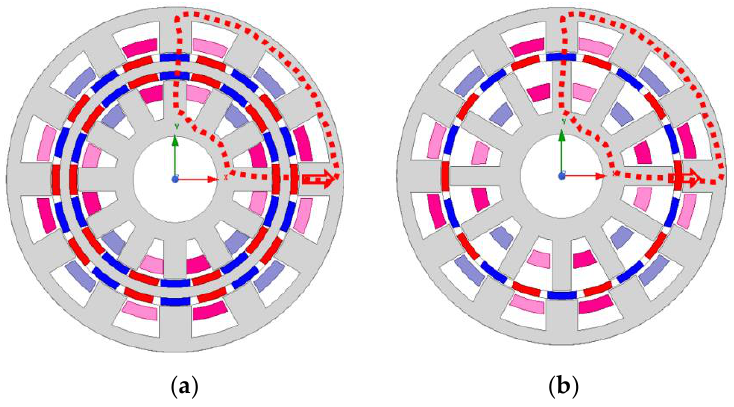
Figure 2. Mesh layout for 2D FEM analysis